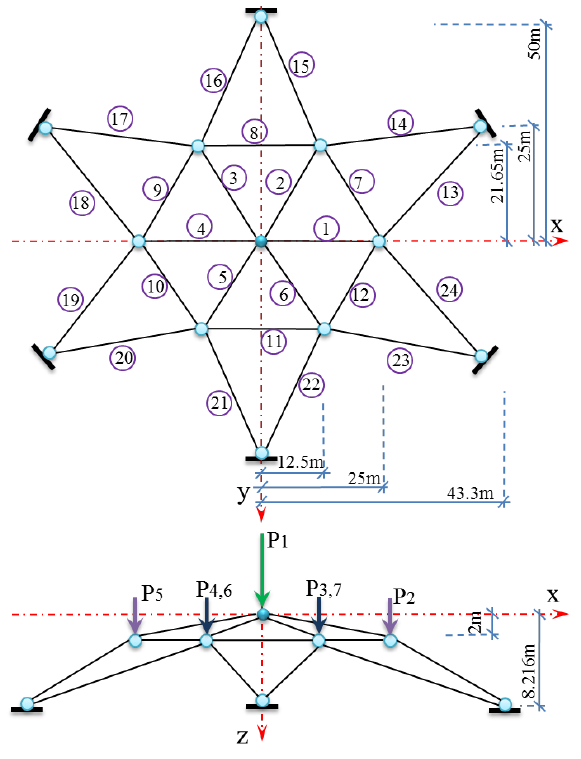
Figure 5. Dam truss structure for Example 3. Table 2. Random variables for dam truss example.